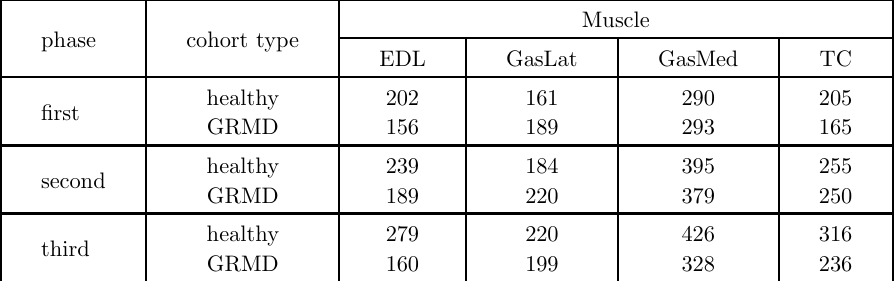
Table 3. Average sizes of ROIs used in the experiments Muscle phase cohort type EDL GasLat GasMed